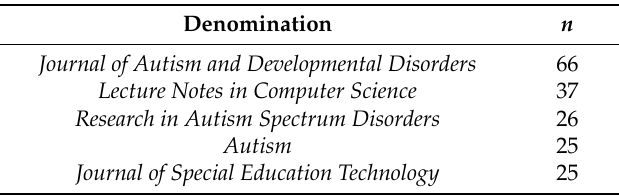
Table 7. Sources of origin.